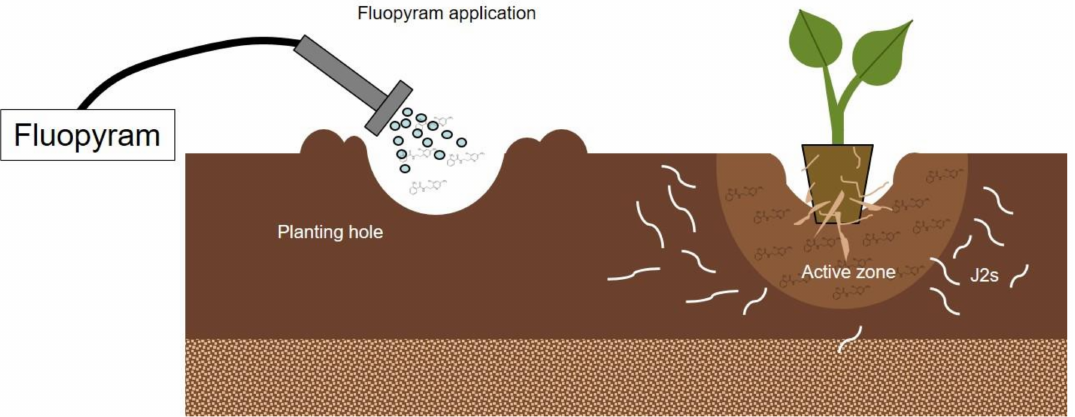
Figure 6. Schematic diagram of planting hole treatment for the control of Meloidogyne incognita in the root zone of the plant. The active zone represents the area in which M. incognita can be controlled by the application of fluopyram into the prepared planting